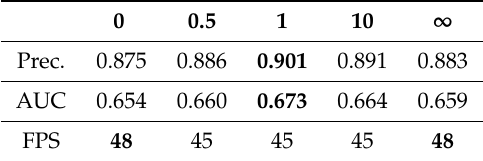
Table 1. Analysis the accuracy and speed of the proposed method depend on α . The best results are in